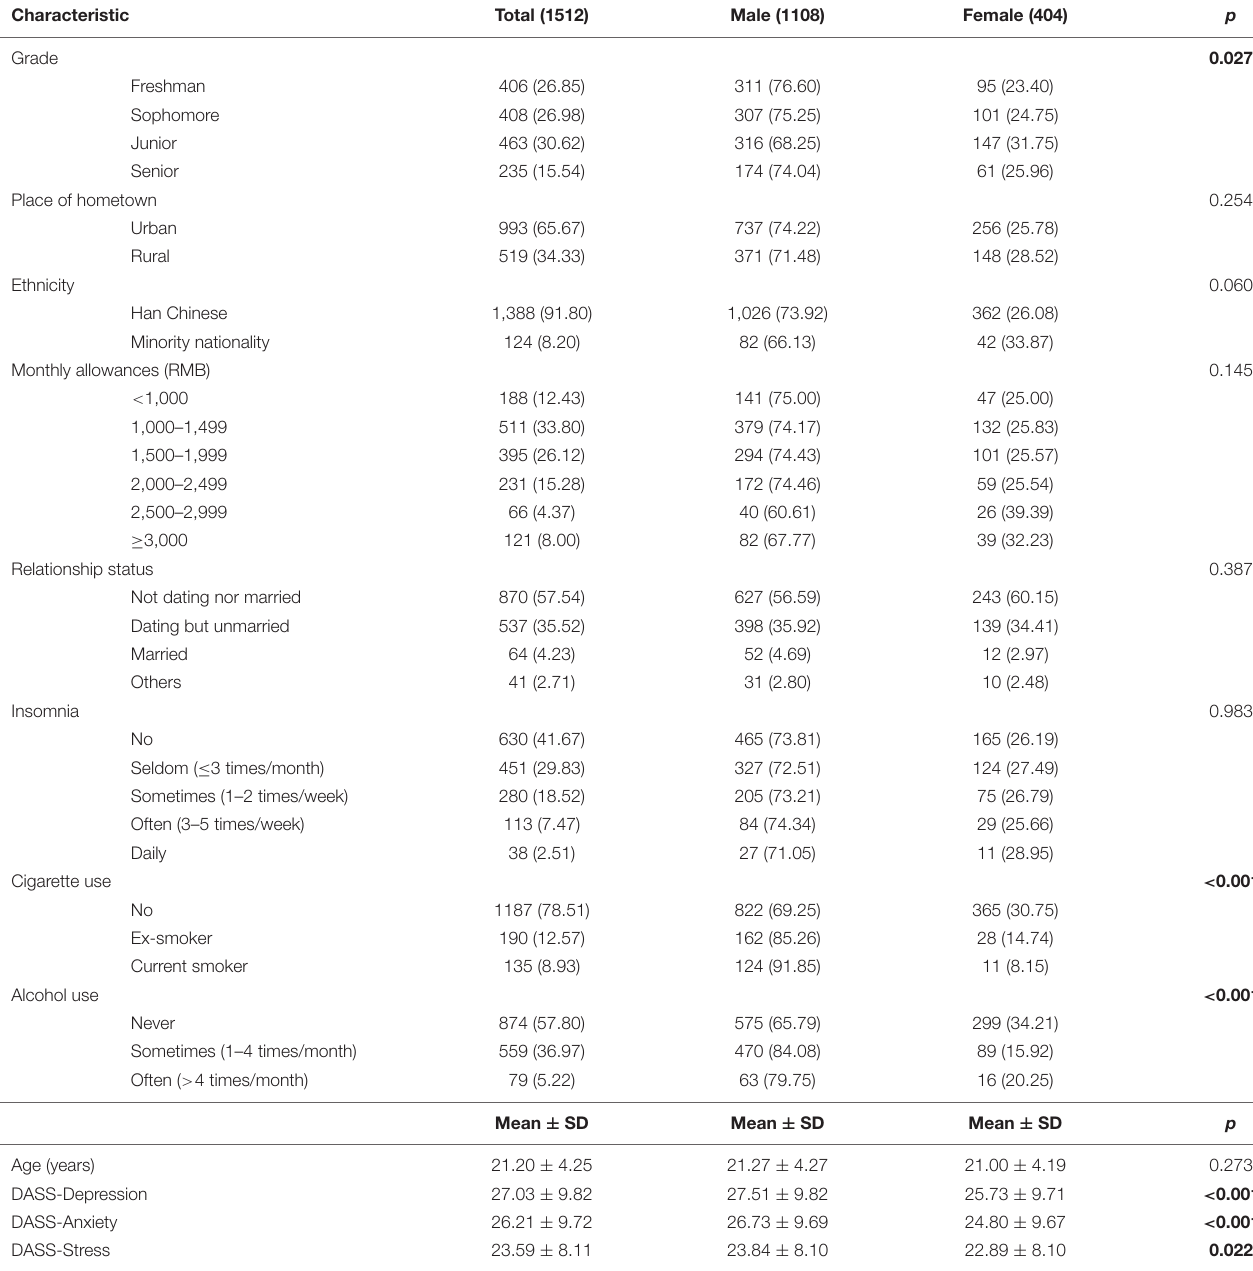
TABLE 1 | Characteristics of participants by gender, n